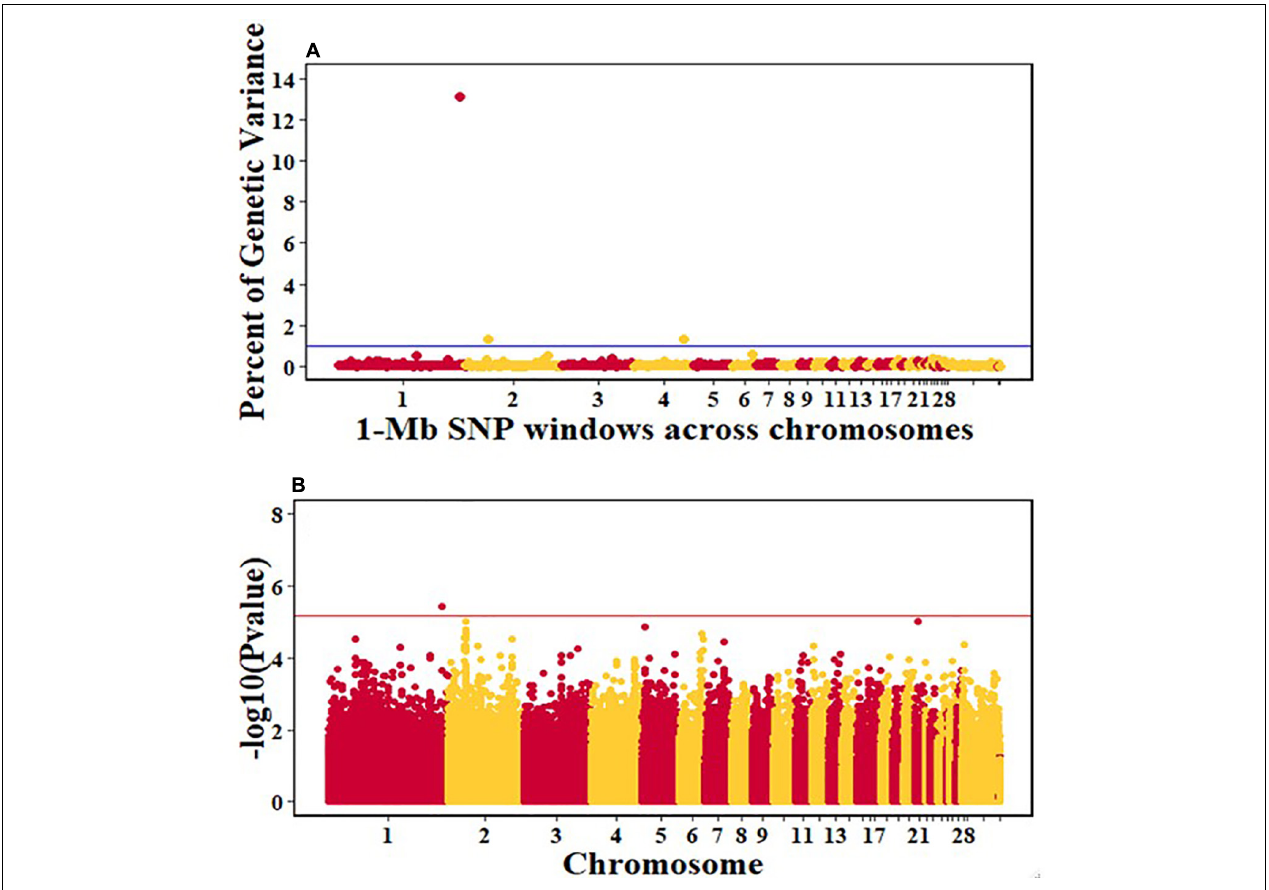
FIGURE 4 | Manhattan plots showing the genome-wide association results for post-infection growth rate in the Ghana local chicken ecotypes population, using Bayes-B and single-SNP analyses. (A) Bayes-B results showing the percent of genetic variance explained by SNPs in 1-Mb non-overlapping windows across chromosomes. (B) Single-SNP results showing the -log10(Pvalue) of ordered SNPs across the chromosomes. The blue and reds lines indicate genome-wide significance at 1% genetic variance and 20% genome-wide suggestive association,